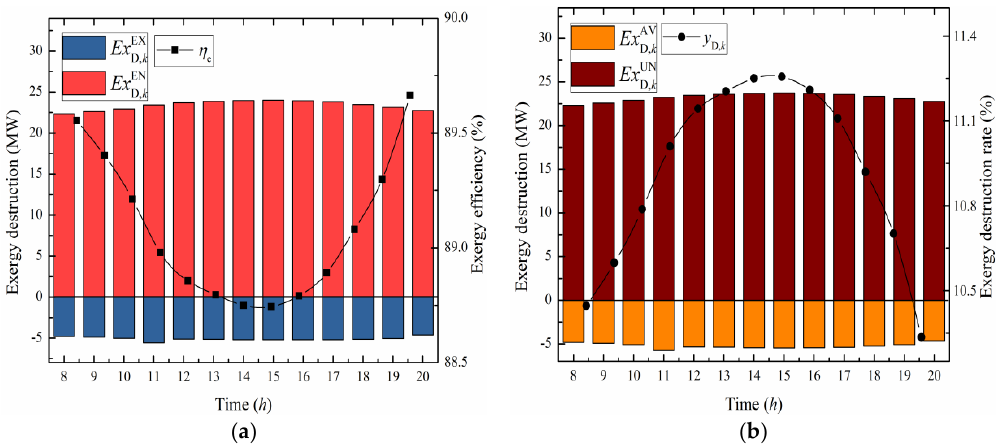
Figure 7. The exergy destruction, exergy efficiency and exergy destruction rate of HRSG variation with time. ( a ) The endogenous/exogenous exergy destruction and exergy efficiency variation with time. ( b ) The avoidable/unavoidable exergy destruction and exergy destruction rate variation with time.